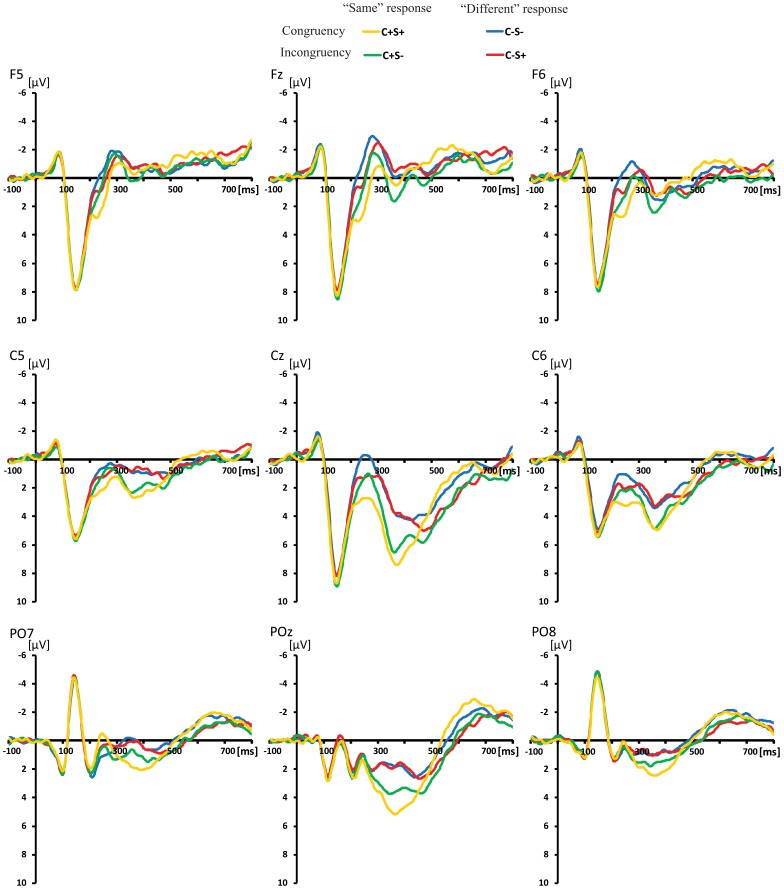
Grand average of the ERP data at the F5, Fz, F6, C5, Cz, C6, PO7, POz, PO8 sites for the C−S−, C−S+, C+S− and C+S+ conditions in the color task.